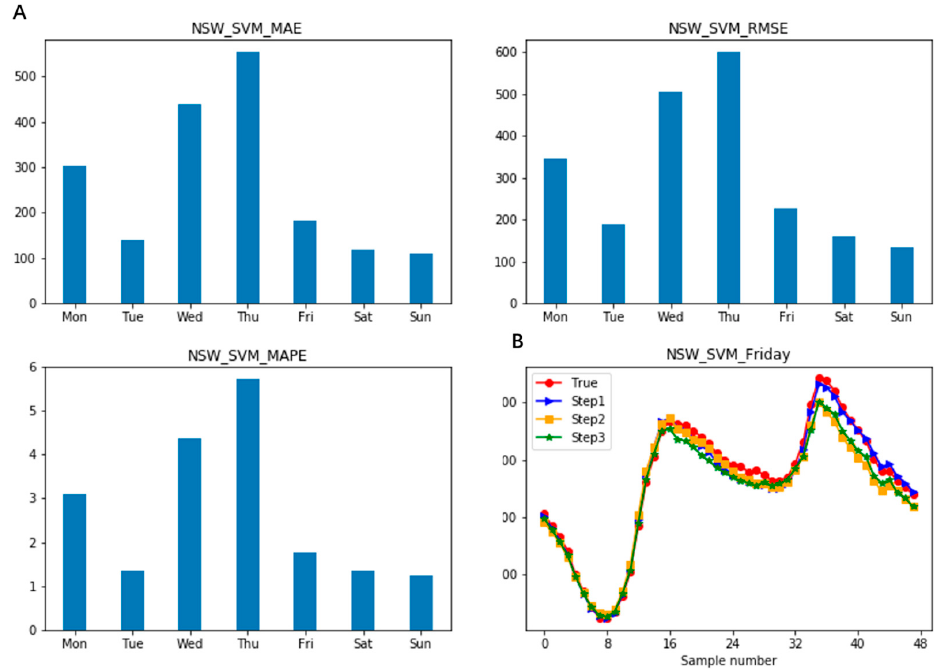
Figure 5. Comparison of the 1-step, 2-step, and 3-step forecasting results of SVM on Friday. ( A ): three evaluation metrics results of SVM. ( B ): SVM forecasting results on Friday.